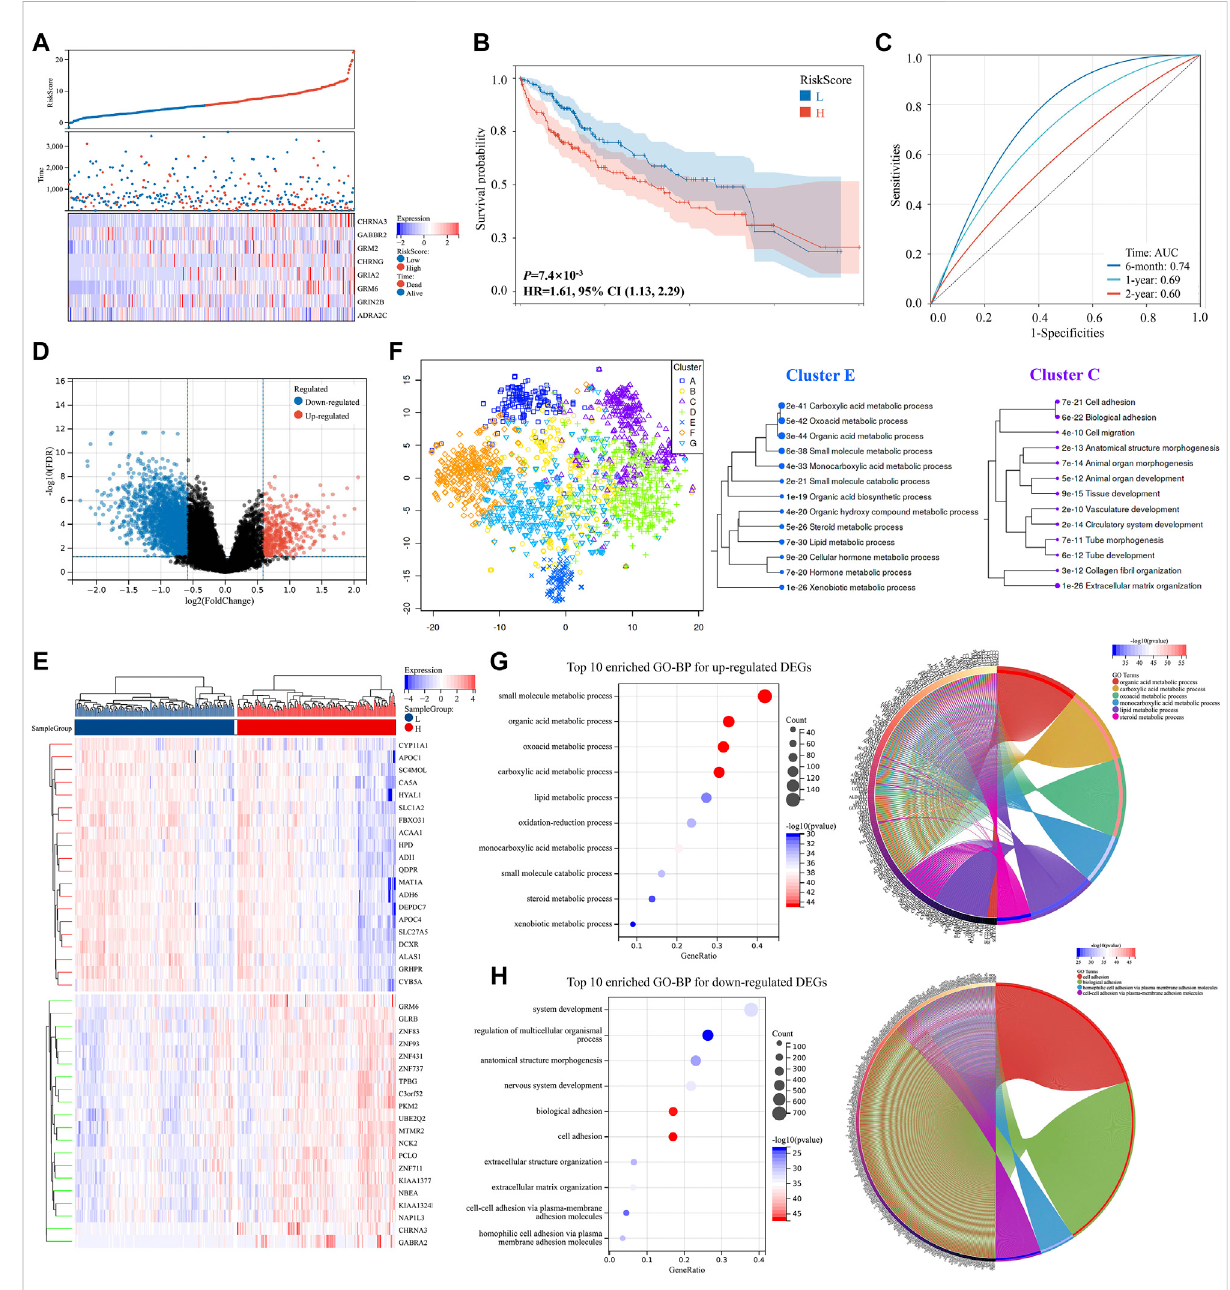
FIGURE 4 DEGsvalidation andpotential pathway enrichmentsintheTCGA-LIHCdataset. (A) Distribution oftheriskscores, survivalstatus, andexpression of the eight critically predictive genes. (B) The Kaplan – Meier analysis of overall survival in the high-risk scores group and low-risk scores group. (C) The ROC analysis to evaluate the predictive ef fi ciency of risk scores. (D) Volcano plot of DEGs. (E) Heat map of DEGs between two groups. (F) Map and clusters of DEGs using t-SNE. (G,H) Top 10 enriched GO-BP and circle plots for DEGs in the TCGA-LIHC datasets. DEGs, differentially expressed genes; t-SNE, t-Distributed Stochastic Neighbor Embedding; GO, gene ontology; BP, biological process. ROC, receiver operator